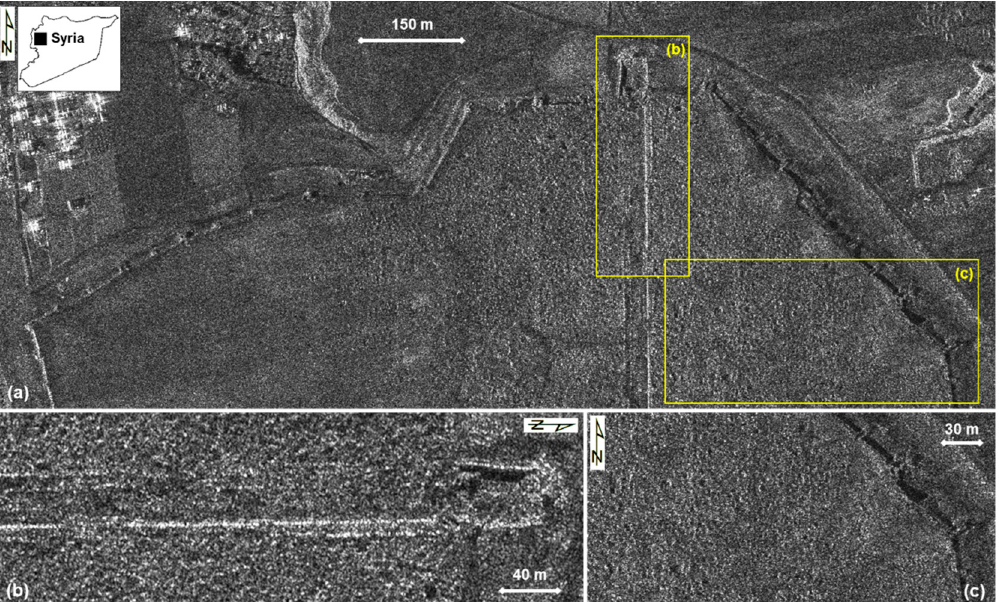
Figure 3. ( a ) Northern sector of the archaeological site of Apamea in Syria captured by a COSMO-SkyMed Enhanced Spotlight image at 1-m ground resolution acquired on 16/07/2018 in ascending mode, using an incidence angle of 41°. Detailed views of: ( b ) the monumental colonnade which appears very bright owing to the high double-bounce; and ( c ) an area of extensive looting, east of the Cardo Maximus. COSMO-SkyMed® Product ©ASI—Italian Space Agency—2018. All Rights Reserved.